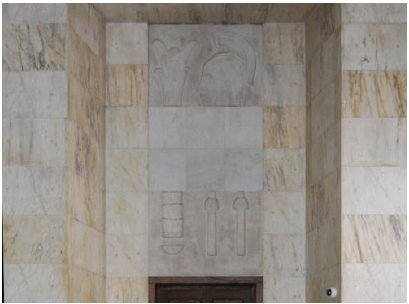
Fig 10. Example of photo-rectified image of a mosaic in the Corte d’Assise d’Appello by